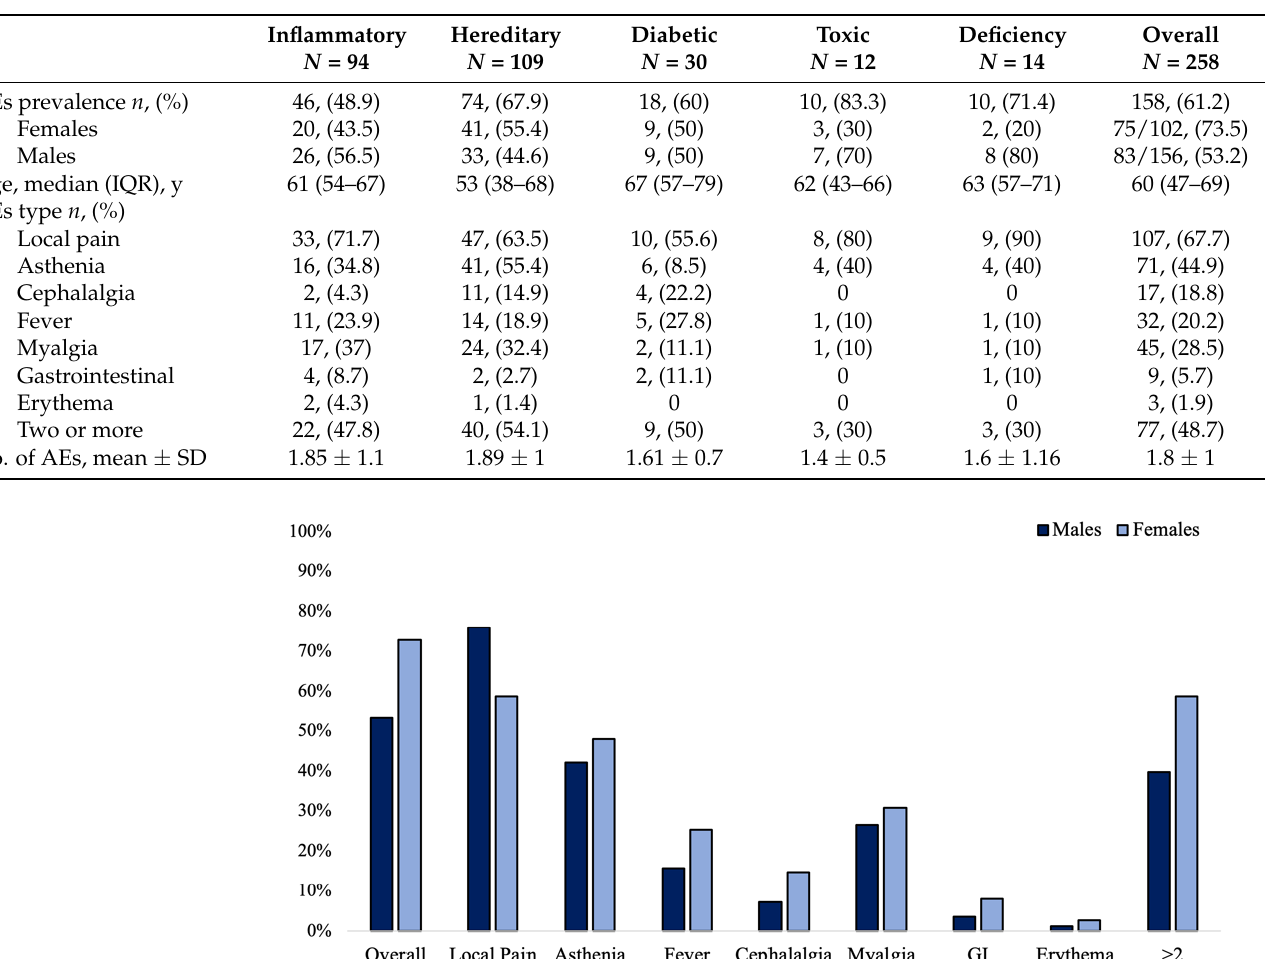
Table 2. Prevalence of AEs in vaccinated patients according to neuropathy subtype.